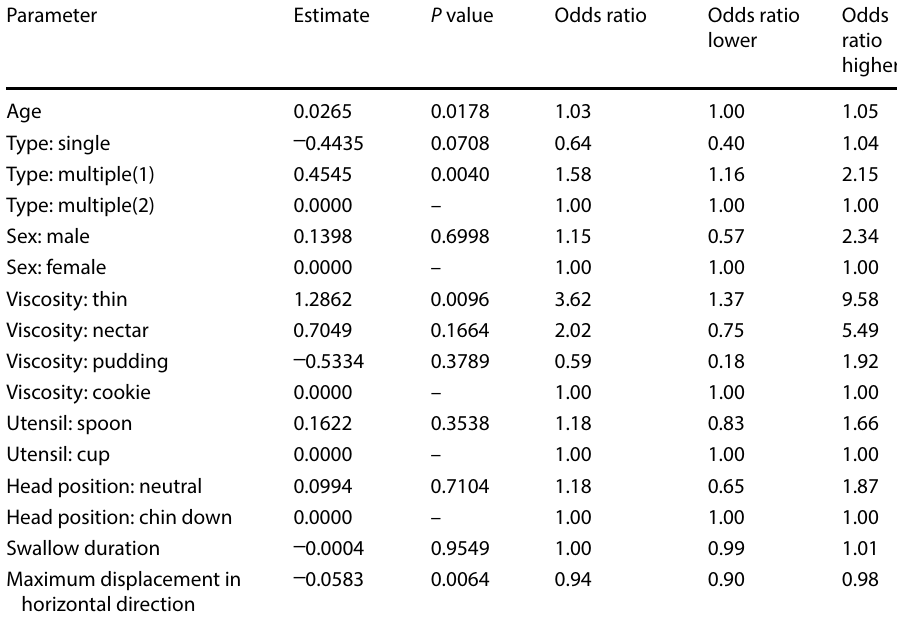
Table 2 Final model with forward selection with 0.05 entry criterion